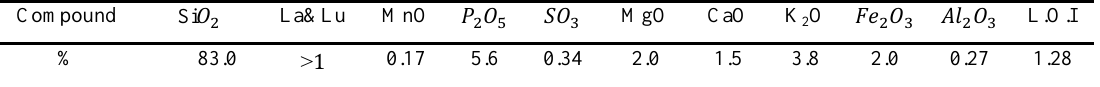
Table 4. Rice husk ash Chemical